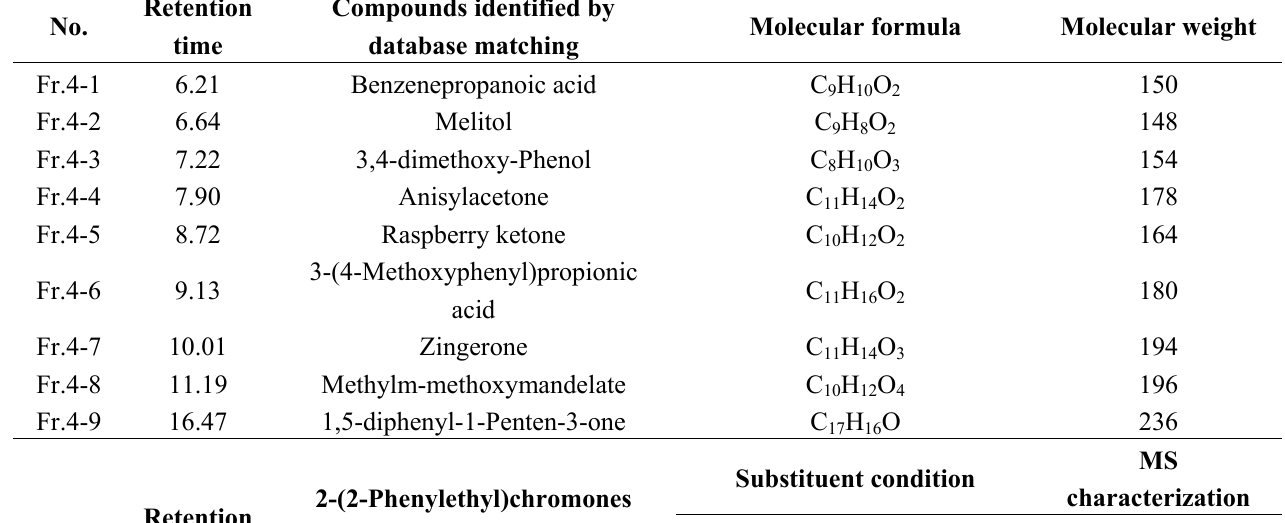
Table 3. 2-(2-Phenylethyl)chromone preliminarily identified by their MS characterization and chemical components identified by database matching of Fraction 4 of agarwood